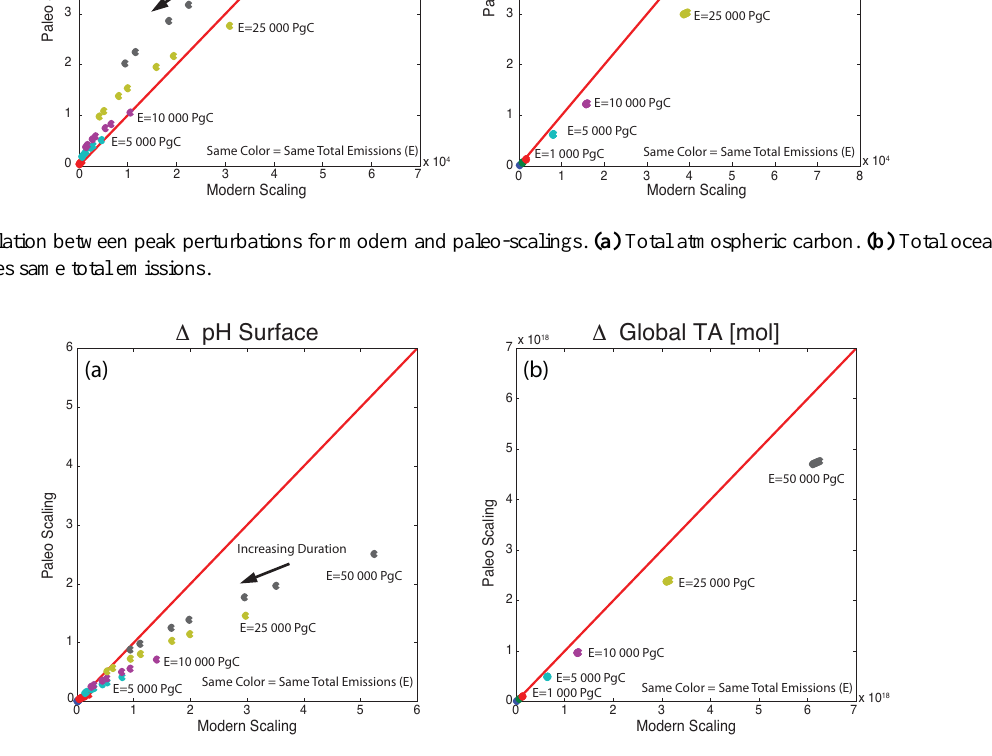
Figure 14. Correlation between peak perturbations for modern and paleo-scalings. (a) Surface pH. (b) Total global alkalinity. Same color denotes same total